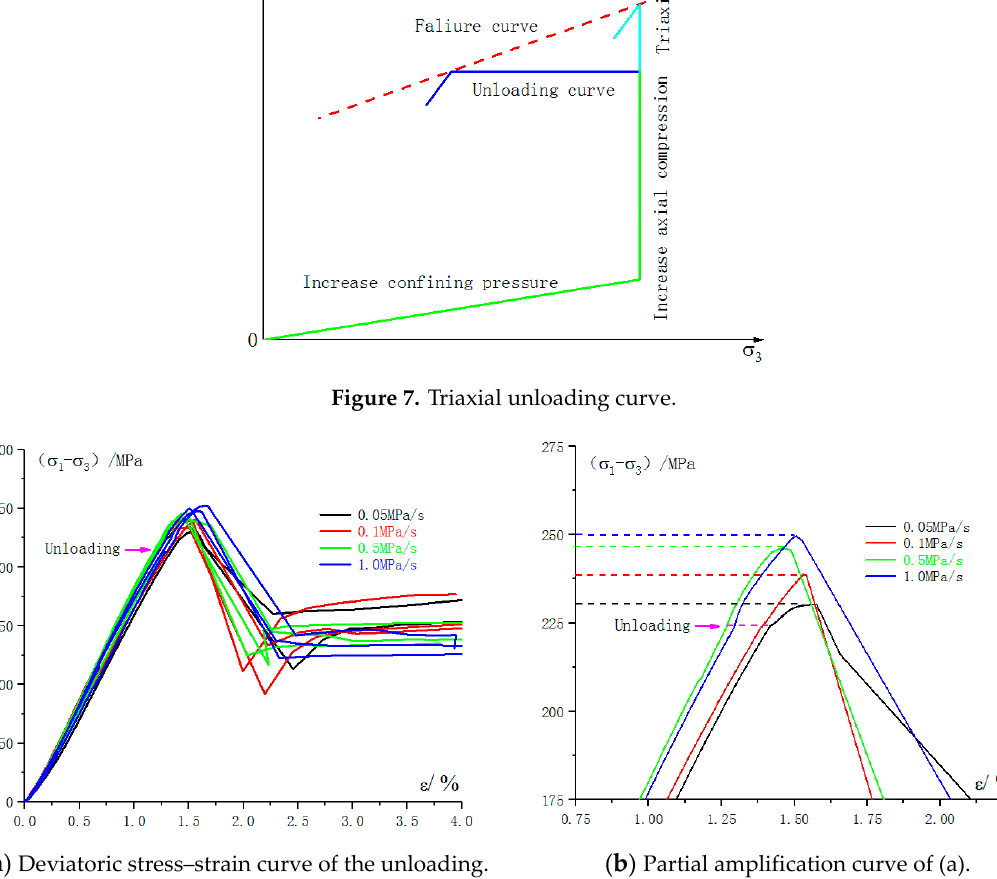
Figure 8. Deviatoric stress–strain curve and partial amplification curve.